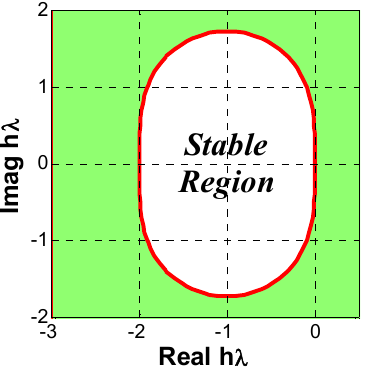
Figure 1. Region of stability of the second-order Runge-Kutta (RK2)